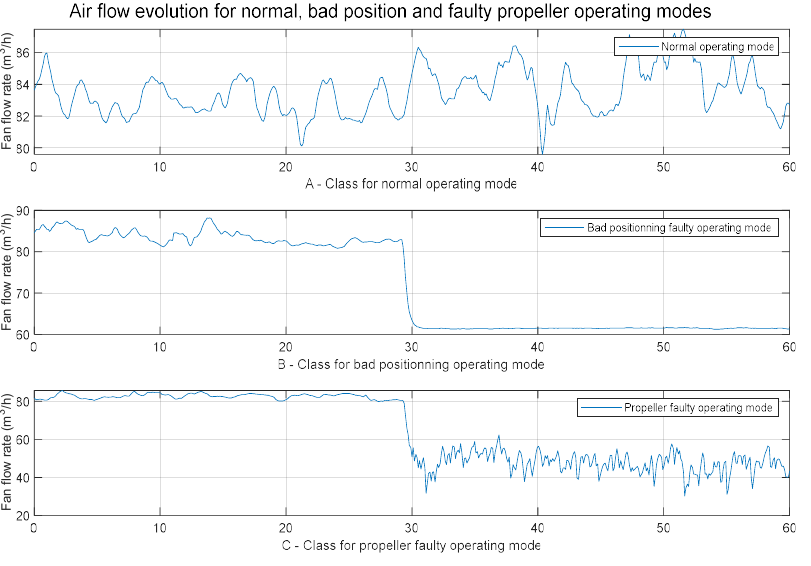
Figure 9. Air flow measurement for normal ( A ), bad positioning ( B ), and propeller faulty operating condition ( C ).